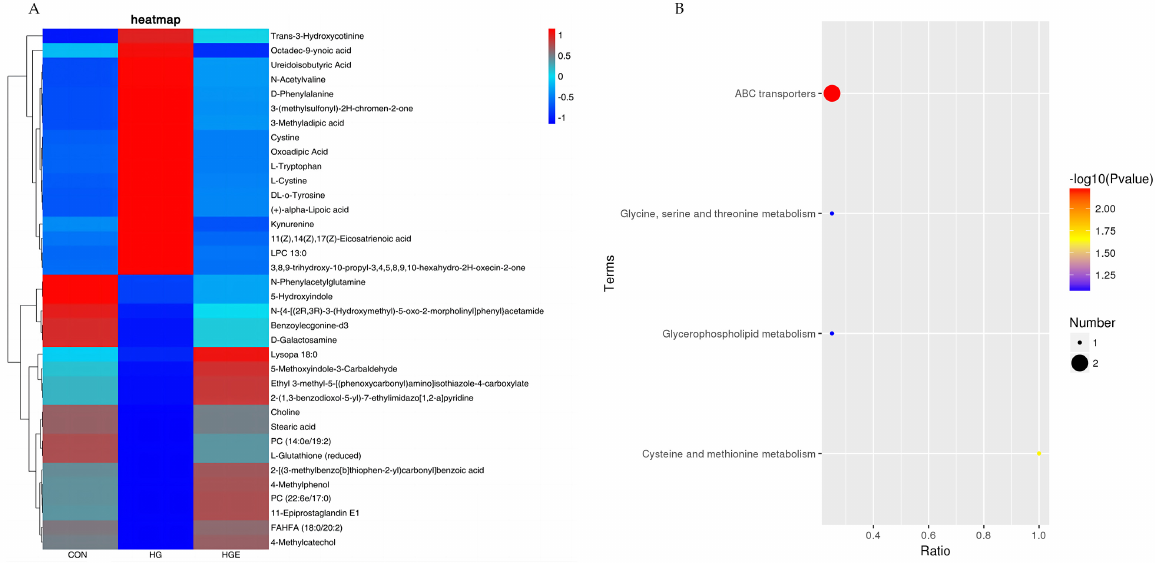
Figure 3. Analysis of common differential metabolite enrichment in CON-HG and HG-HGE. ( A ) Cluster heat map of common differential metabolites, ( B ) KEGG pathway enrichment map of common differential metabolites.